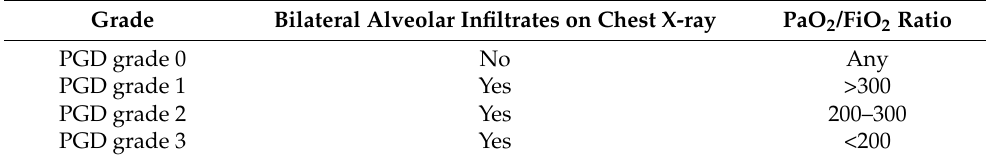
Table 1. Grading of primary graft dysfunction (PGD) after lung transplantation (LTx) according to the 2016 definition of the International Society for Heart and Lung Transplantation